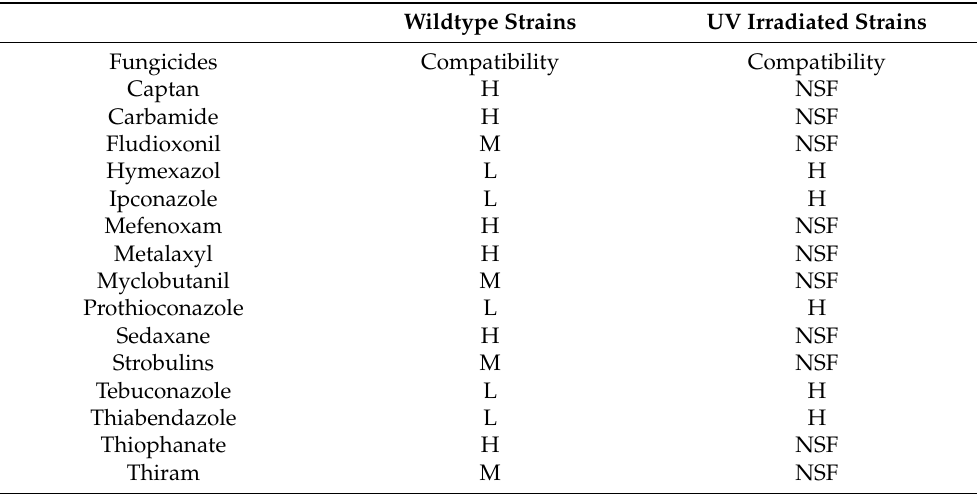
Table 2. Fungicide Compatibility of